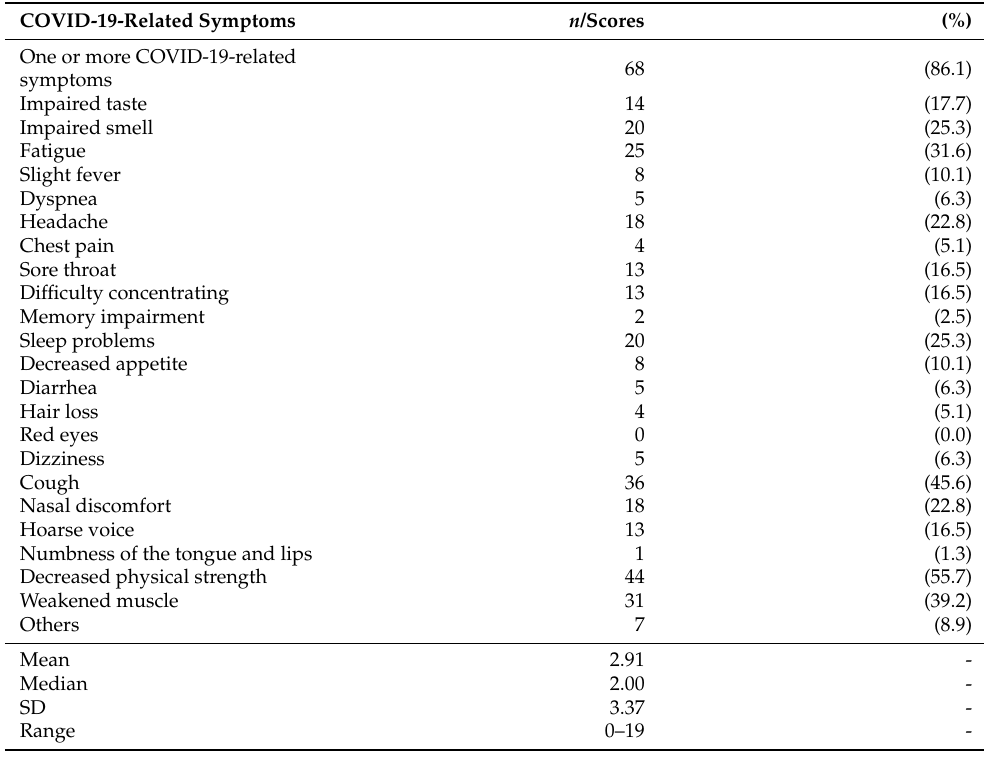
Table 4. Sociodemographic characteristics for COVID-19-related symptoms in PCR-positive HCWs ( n =